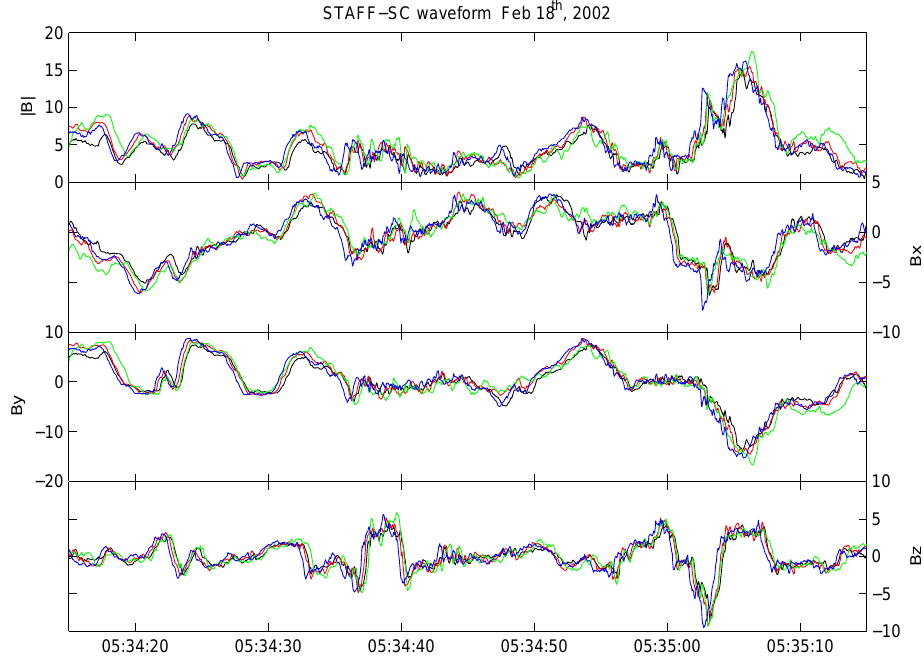
Fig. 1. The magnetic field measured by the STAFF search coil. From top to bottom, the panels show the field magnitude, and the X, Y, and Z components in the GSE frame. The colored lines represent data from Cluster 1 (black), 2 (red), 3 (green), and 4